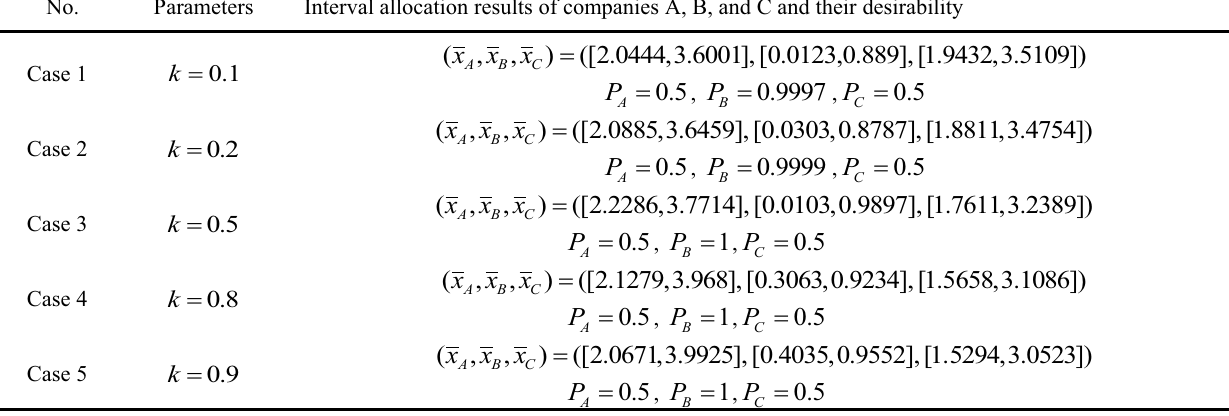
Table 3 Relatively optimal interval core based on desirability function Interval allocation results of companies A, B, and C and their